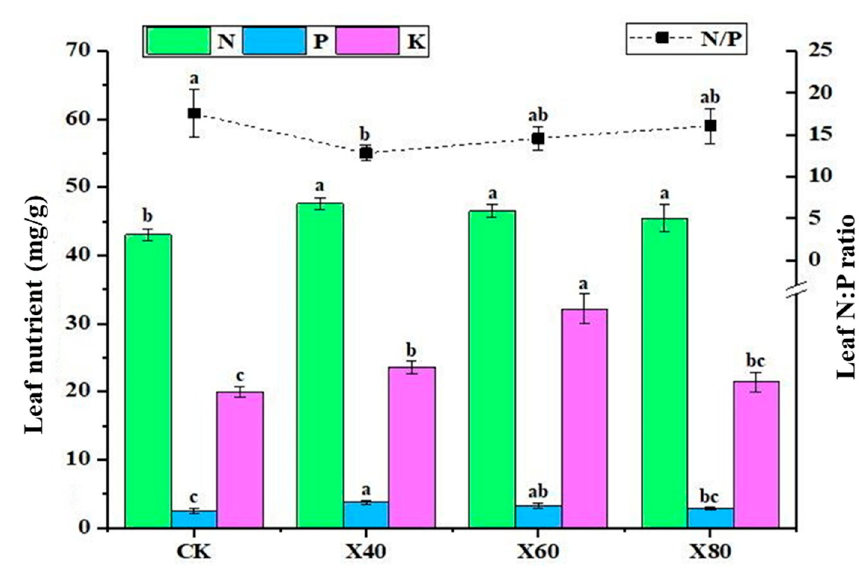
Figure 3. The N, P, and K content and N:P ratio in L. barbarum leaves under different root-restriction treatments. Note: Different letters show significant differences determined by LSD’s test at p < 0.05.